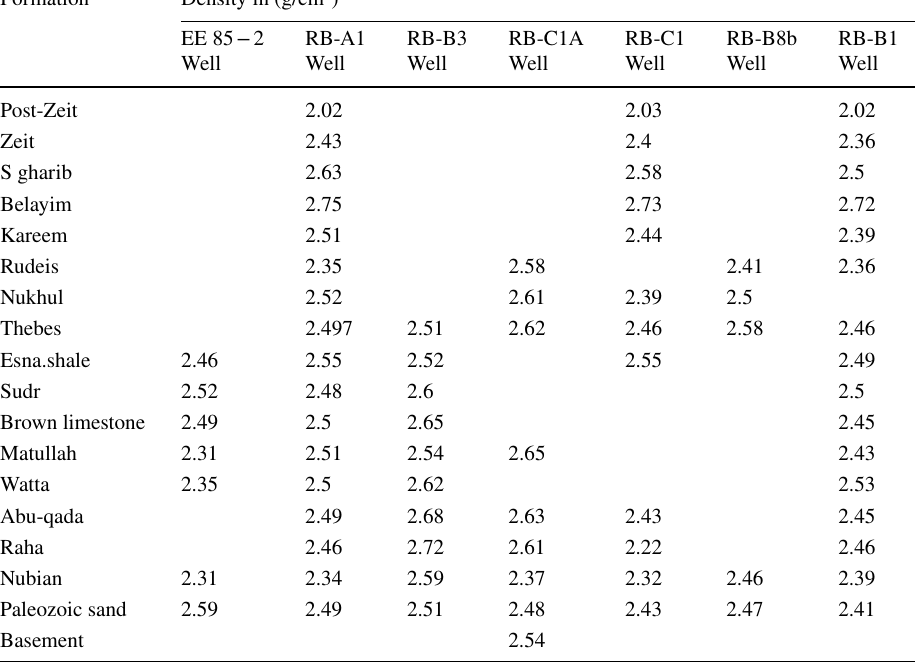
Table 1 Density measurements of different drilled wells in the study area